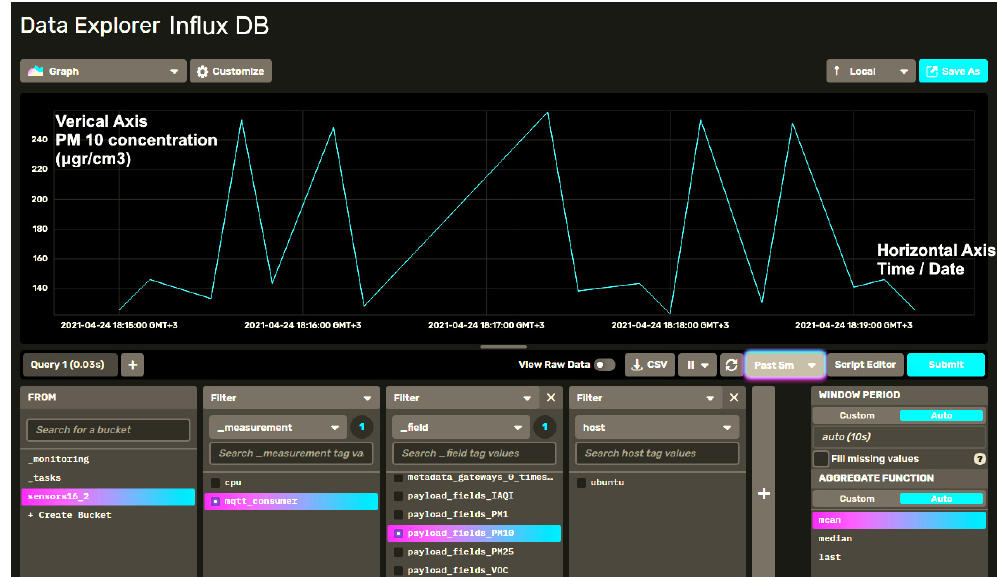
Figure 12. InfluxDB data Explorer visualizing PM 10 accumulated data in time series for the depicted time interval of 5 min.